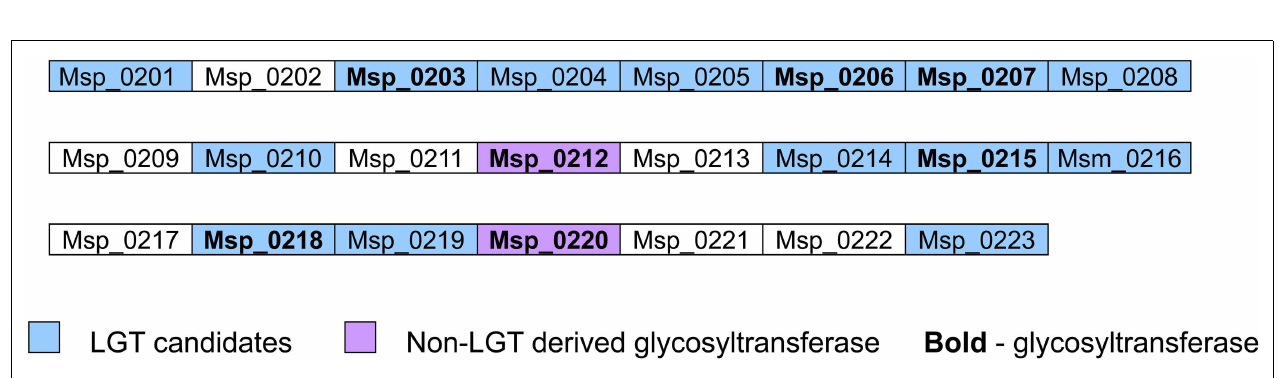
FIGURE 4 |The Msp_0201-Msp_0223 genomic region encoding glycosyltransferase and LGT candidates.